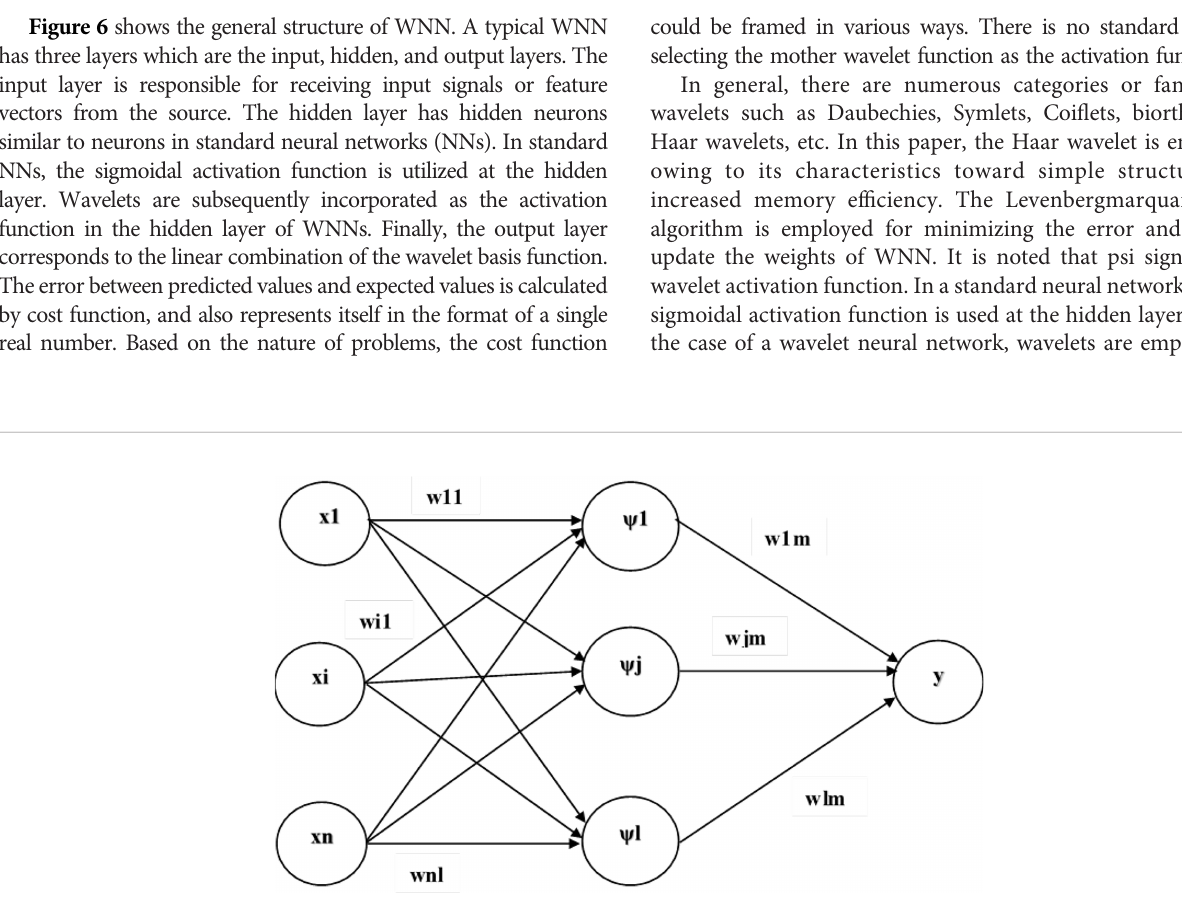
FIGURE 6 | Structure of